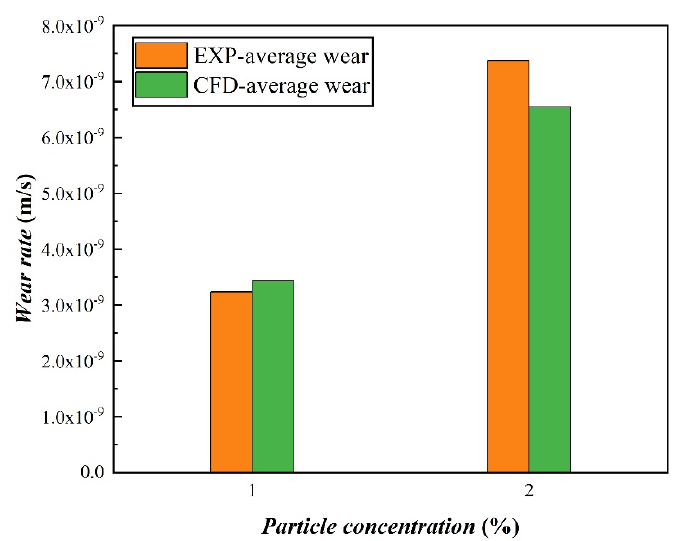
Figure 5. Comparison of the experimental and simulated results of aluminum sheet wear rate.